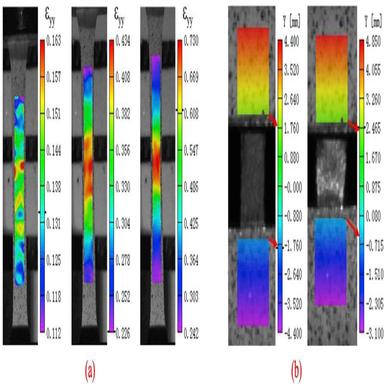
(a) Contours of the axial strain during the uniaxial tension and, (b) variation of the axial platen position during the uniaxial compression obtained with HT-DIC system.